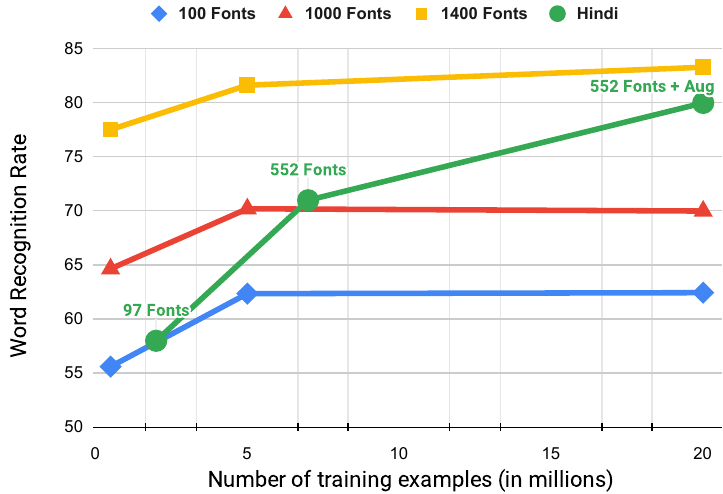
Figure 3. Comparing STAR-Net’s performance on IIIT5K [48] dataset (blue, red, and yellow plots) and IIIT-ILST [4] Hindi dataset (green plot) when trained on synthetic data created using a varying number of fonts and training